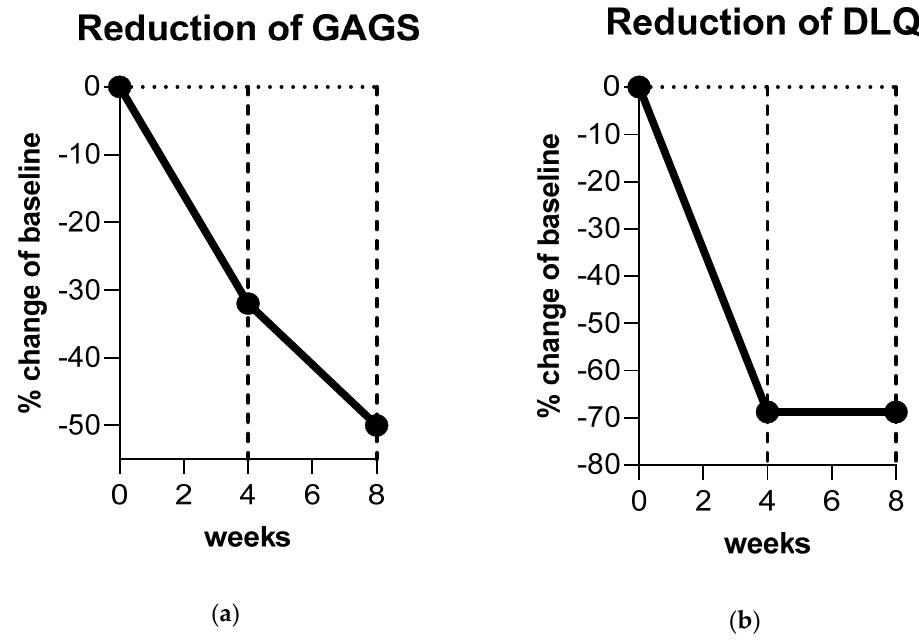
Figure 2. Clinical improvement of acne vulgaris. ( a ) The Global Acne Grading System (GAGS) score was reduced by 32% after eight weeks of nitric oxide (NO)-producing gel treatment. ( b ) The Dermatology Life Quality Index (DLQI) more than halved resulting in an approximately 70% reduction, indicating only a minor remaining decreased quality of life after treatment with NO-producing gel formulation.